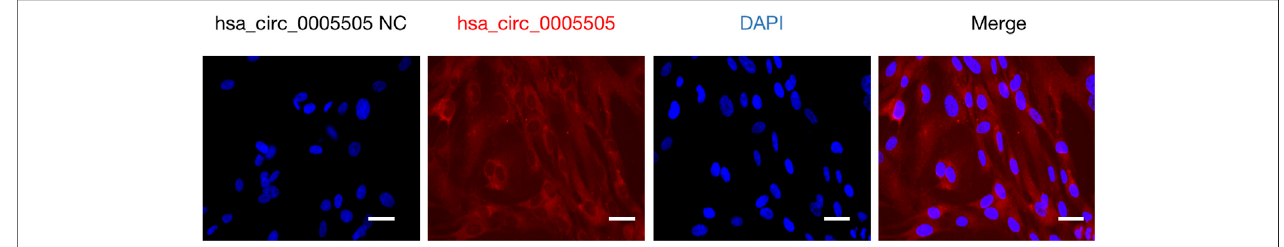
FIGURE 5 | Fluorescence in situ hybridization assay showing cytoplasmic localization of hsa_circ_0005505 in HBVSMCs. Scale bar (cid:1) 25 μ mm. NC (cid:1) negative control.